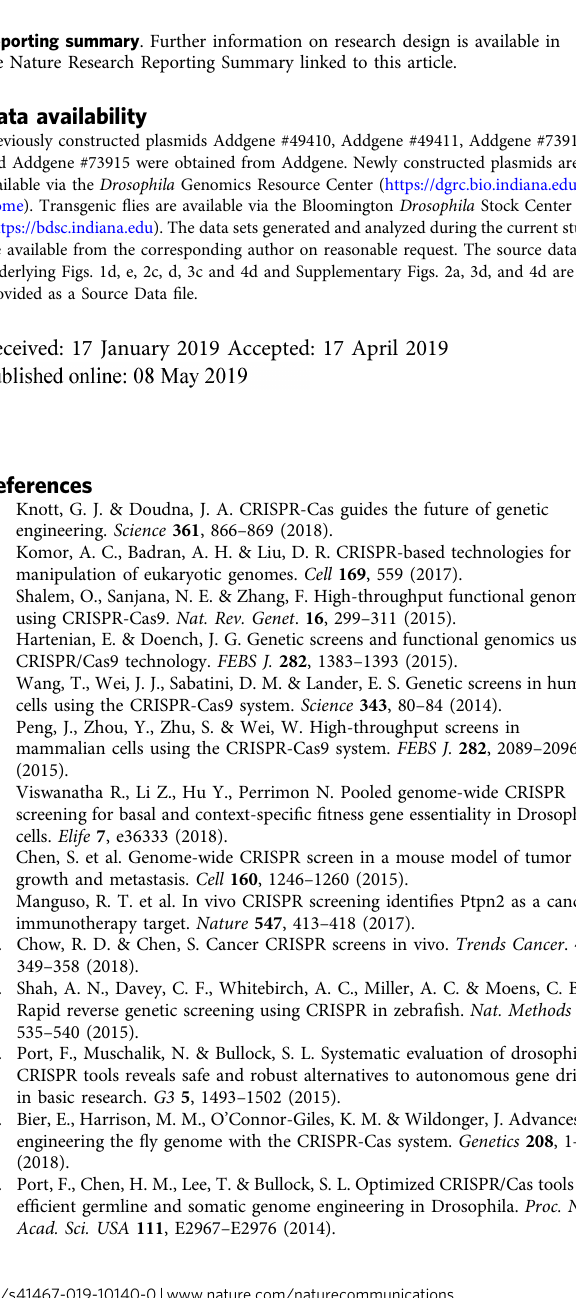
Figure 3b. (WT) y,w;R71G10,CD8/ + ; Cas9.C/ + (CG9003) y,w/y,v;R71G10, CD8/ + ;Cas9.C/CG9003-gRNAx2 pCFD4